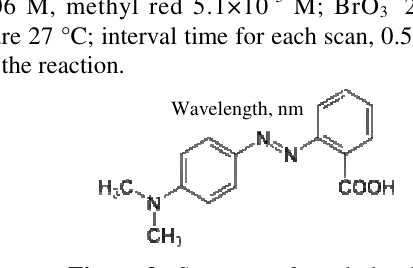
system with time. 3